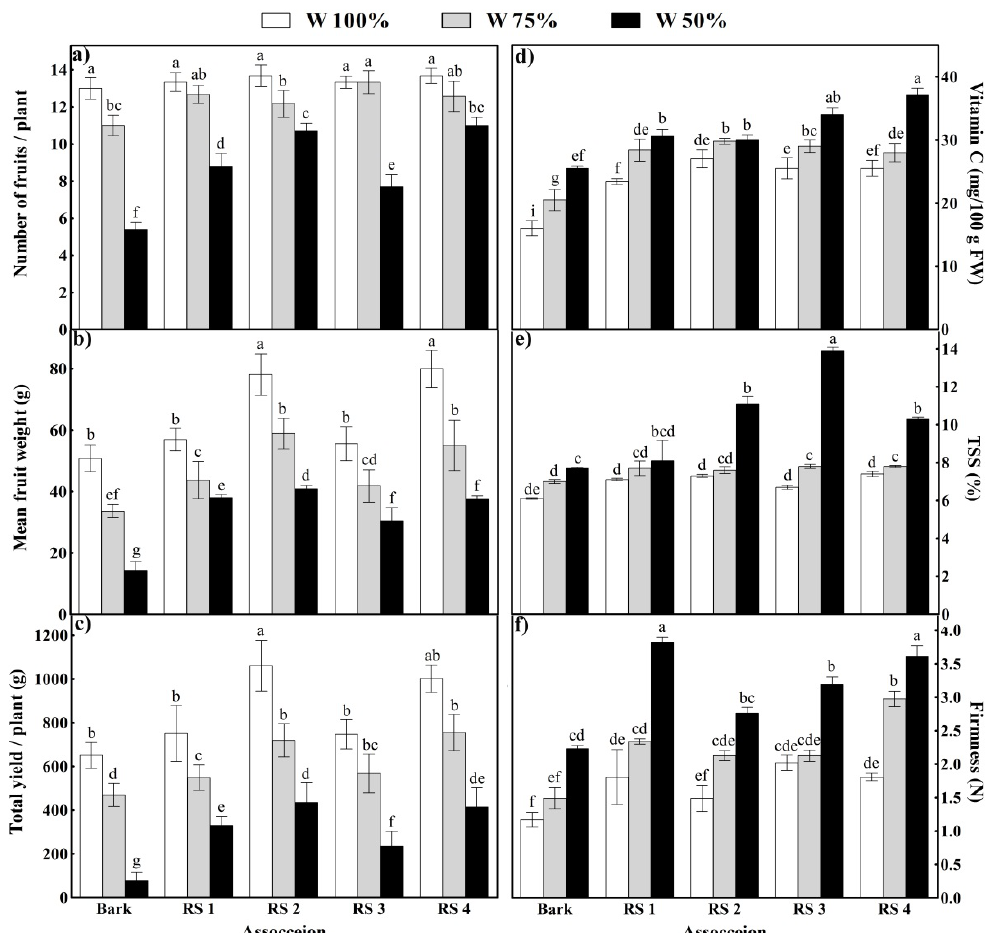
Figure 3. Effect of interaction between drought treatments and rootstock on ( a ) number of fruit/plant, ( b ) mean fruit weight, ( c ) total yield/plant, ( d ) vitamin C content, ( e ) TSS and ( f ) firmness. Different letters indicate significant differences between treatments (Tukey test at p < 0.05).